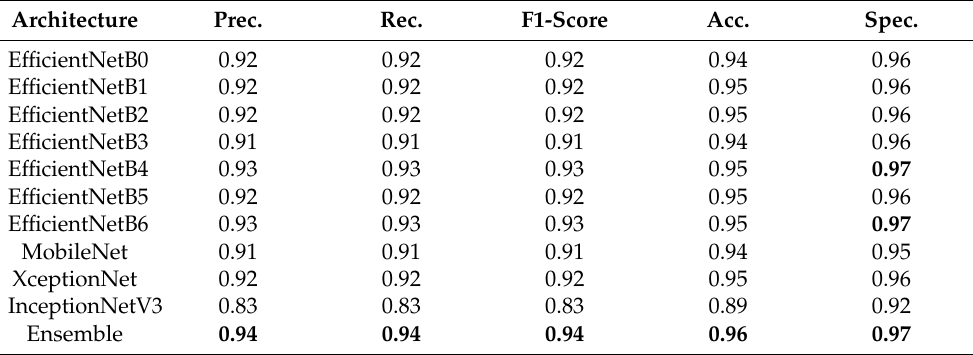
Table 6. Results for the three-class classification. The best results for each metric are highlighted in